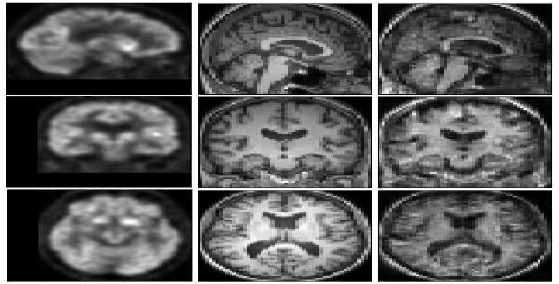
Figure 4. A pair of FDG-PET (left image), the ground truth T1 weighted MRI (middle image), and the generated image (right image) with E-GAN.